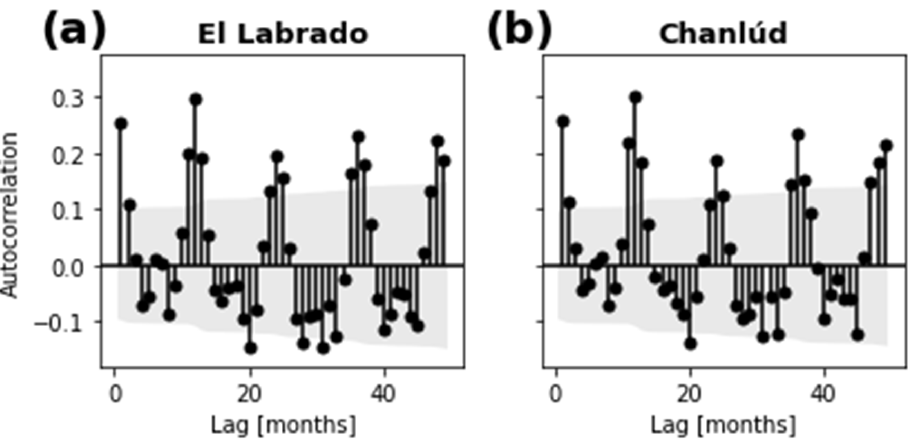
Figure 3. Autocorrelation of rainfall signals and 95% confidence intervals in gray: ( a ) El Labrado; ( b ) Chanlúd.